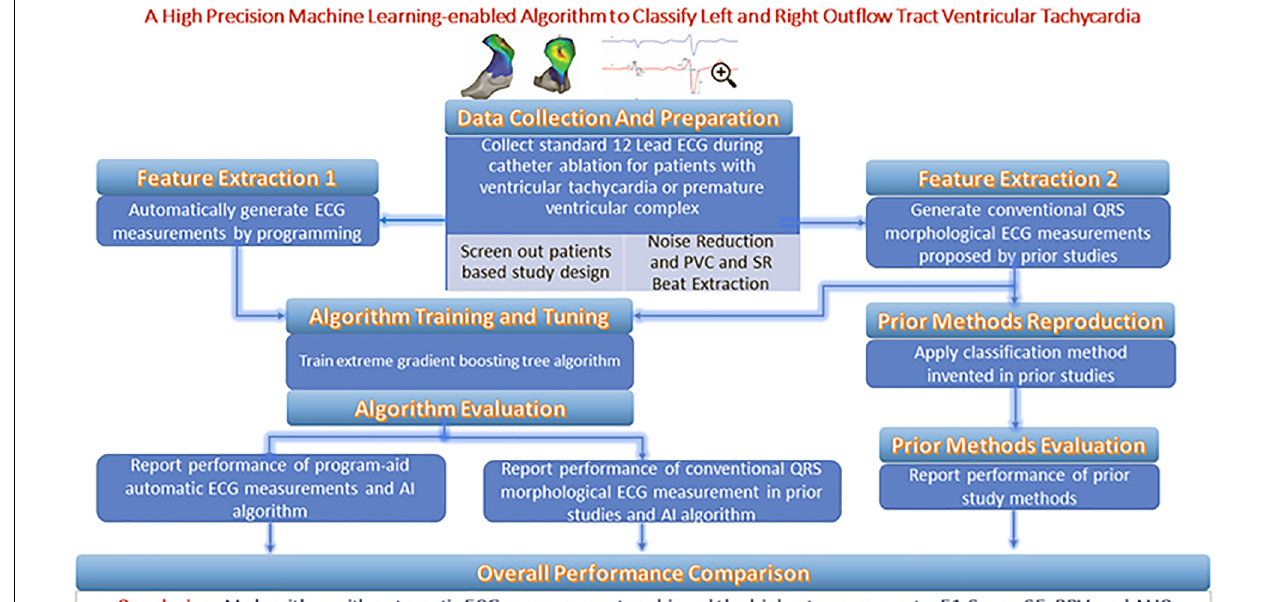
FIGURE 1 | Central illustration.